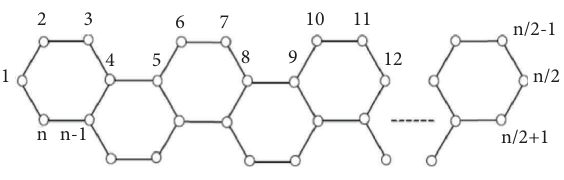
Figure 3: Te zig-zag hexagonal chain I [ 2 k + 1 ]